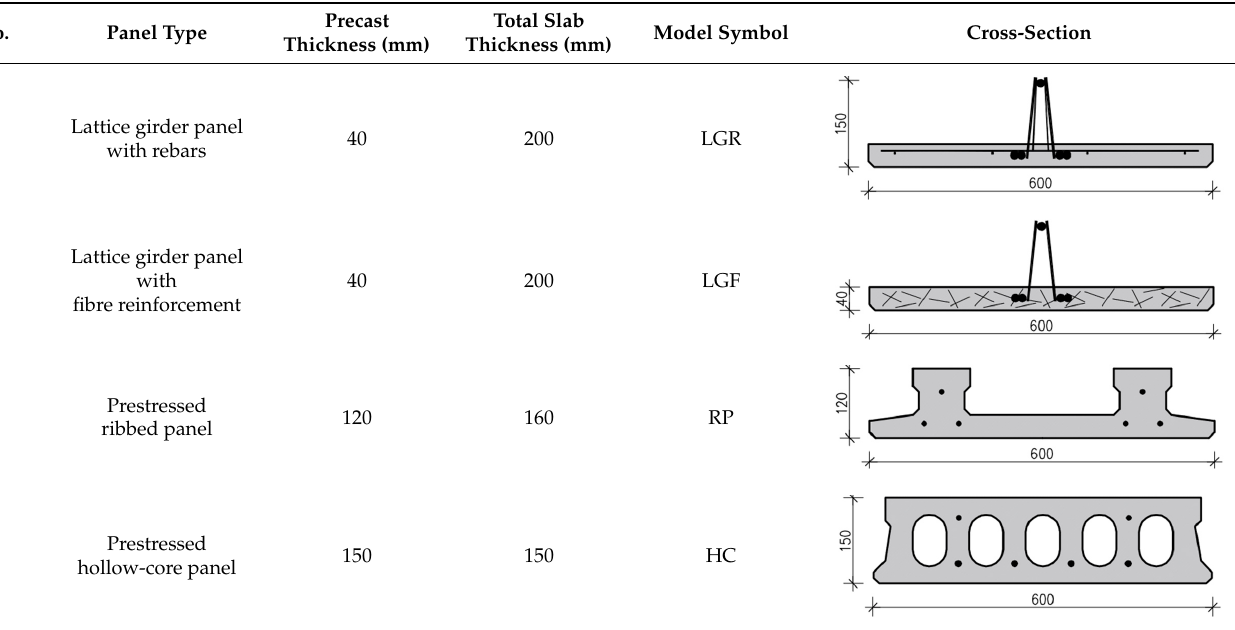
Table 1. Basic parameters of the models.